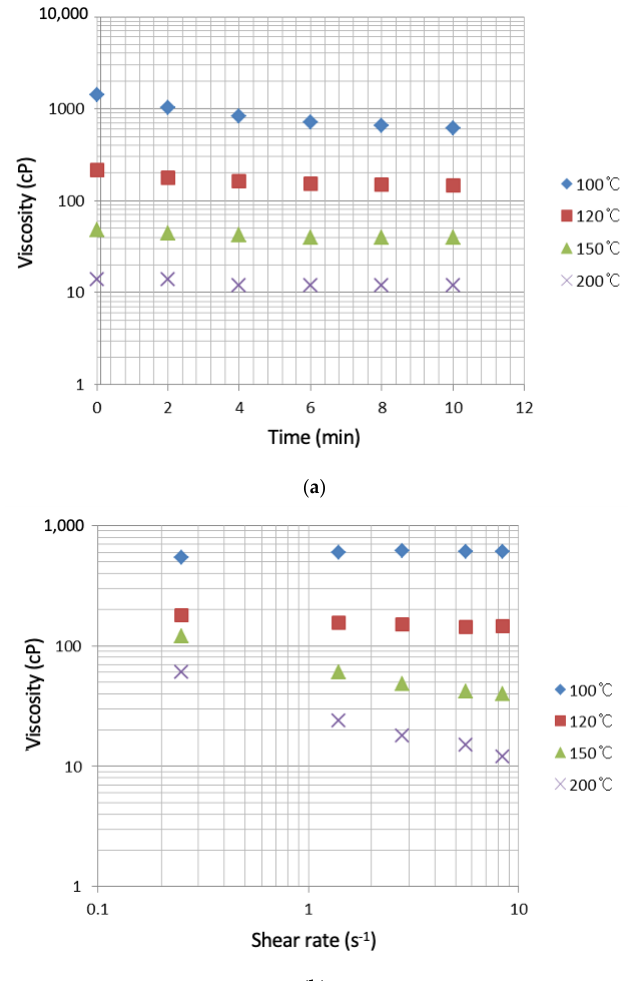
Figure 3. Rheological behaviors of purified (QI-removed) coal tar pitch: viscosity vs. time ( a ) and viscosity vs. shear rate ( b ) at different temperatures (100 to 200 ◦ C).